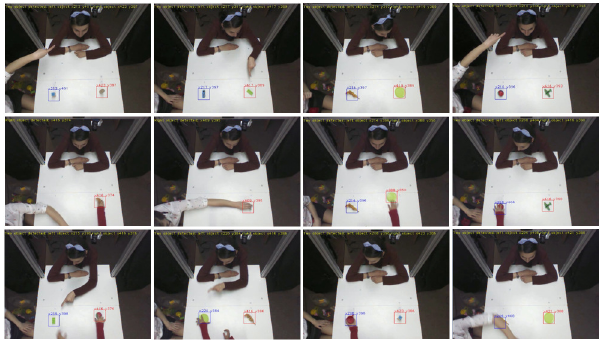
Figure 8: Object detection and tracking